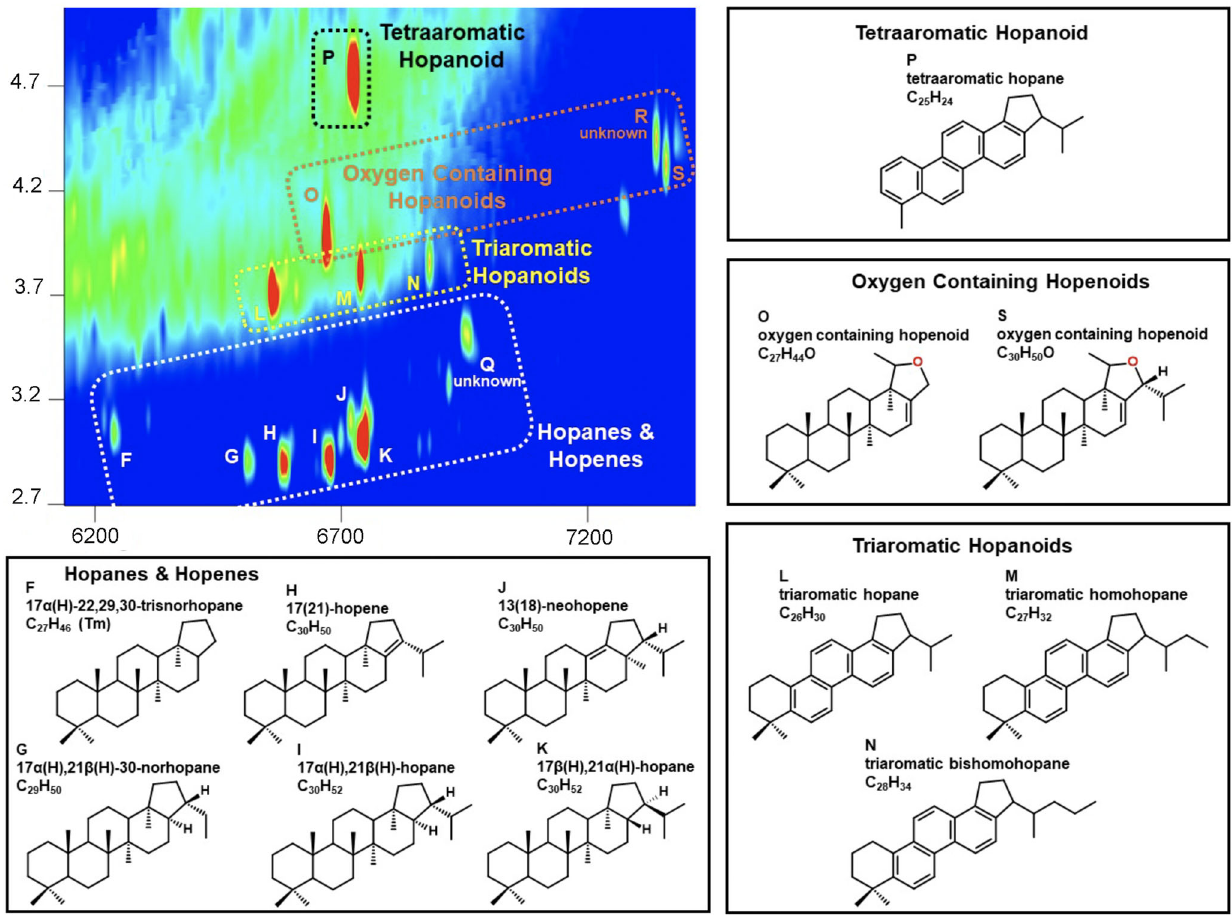
Fig. 7 GC×GC-HRT color contour plot of Cathedral Hill core 4991-7 (0 – 6 cm) highlighting hopane degradation and oxidation products, using selected ions ( m / z 123.117, 191.179, 257.132, 281.133, 324.187, 410.391, and 412.406 all ±0.005 amu). Peak assignments start at F to correlate with Supplementary Fig. S11 panel b. Peaks F, G, I, and K are the hopanoids 17 α (H),22,29,30-trisnorhopane, 17 α (H),30-norhopane, 17 α (H),21 β (H)-hopane, and 17 β (H),21 α (H)-hopane (aka moretane), respectively. Peaks H, J, and Q are the hopenes identi fi ed as 17(21)-hopene, 13(18)-neohopene, and an unknown hopene, respectively. Peaks L, M, and N are triaromatic hopane, triaromatic homohopane, and triaromatic bishomohopane, respectively. Peaks O, R, and